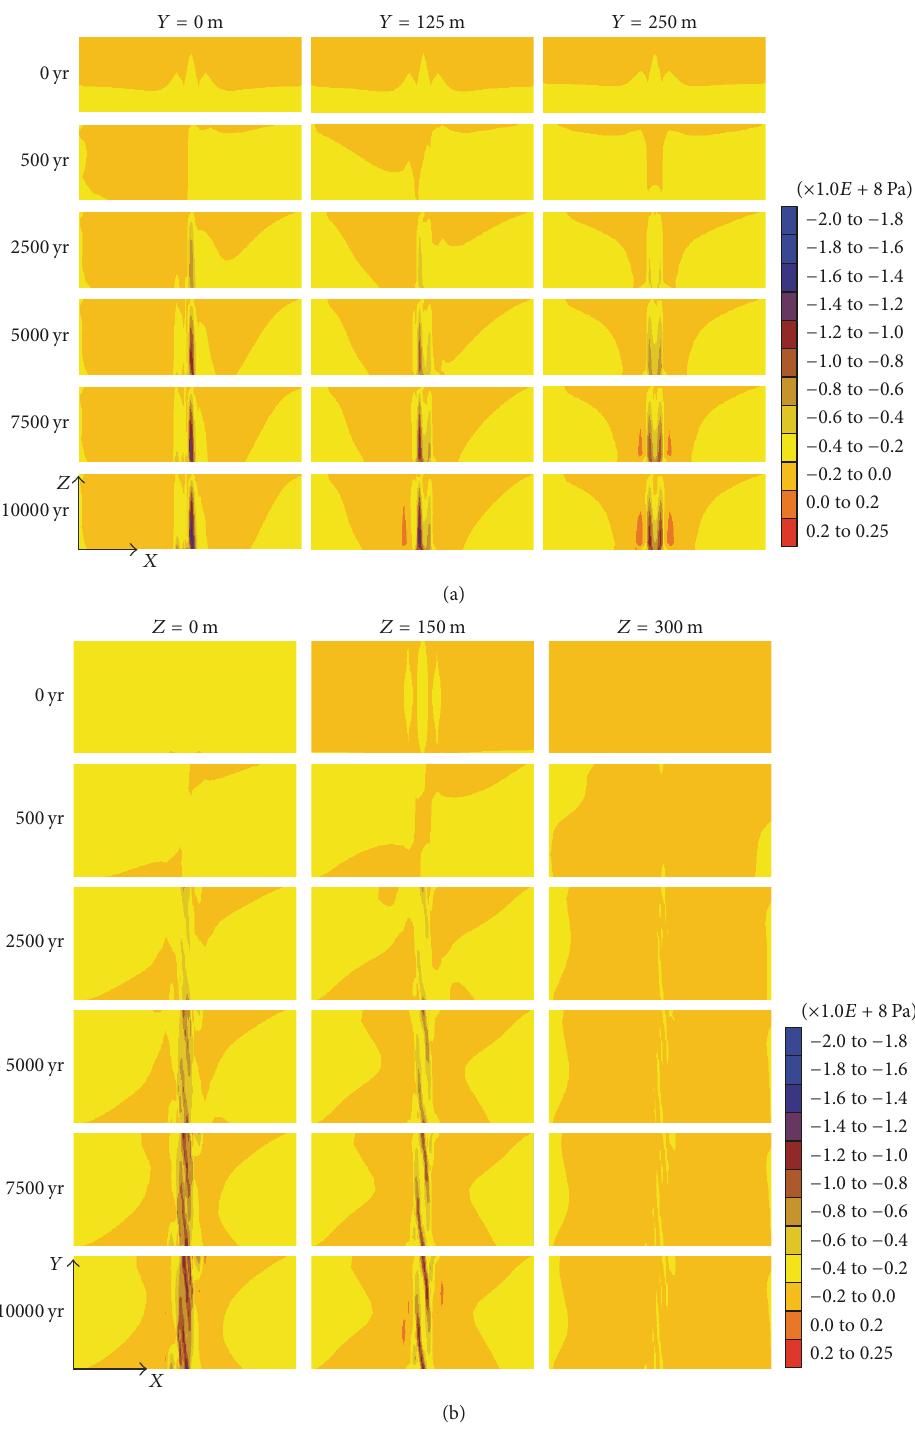
Figure 3: Contour map of the maximum principle stress ( 𝑆 max ) for Model II at different times. (a) is three vertical cross sections of 𝑌 = 0 , 125 m, and 250 m; (b) is three horizontal cross sections of 𝑍 = 0 , 150m, and 300